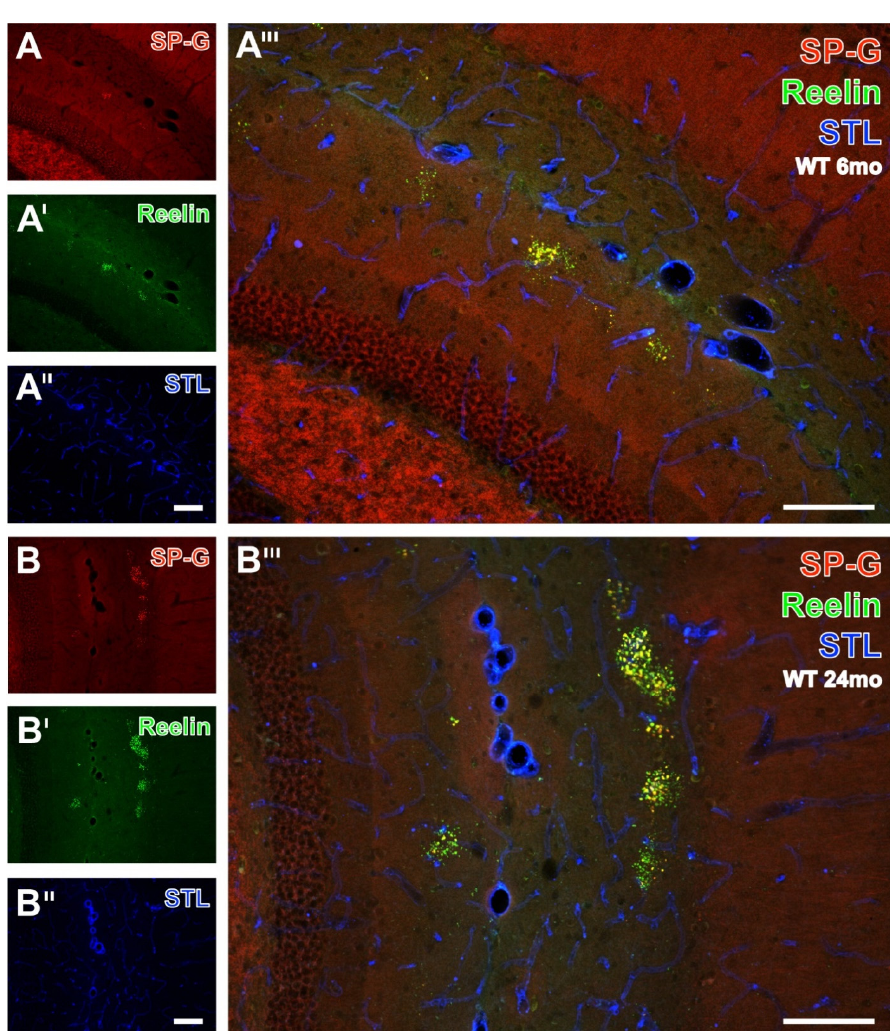
Figure 9. Double immunolabeling of SP-G- and Reelin combined with the detection of endothelia by STL in the hippocampus of 6 and 24 month-old WT mice. In a 6 month-old animal, the presented SP-G-ir remains restricted to the stratum lacunosum-moleculare of the CA1-region in a more ros- trally located part of the hippocampus and is in some cases not clustered ( A ). Concomitantly, Reelin- ir reveals apparently more dot-like structures ( A’ ) exclusively in the stratum lacunosum-moleculare. Additional counterstaining of endothelia with STL ( A’’ ) also visualizes some perpendicularly cut vessels of the fissura hippocampalis. The overlay ( A’’’ ) indicates the lacking co-occurrence of vas- culature and dot-like structures which are either mono-labeled by Reelin (green) or contain SP-G as well as Reelin (yellow). The same triple staining in the caudal, laterally positioned hippocampus from a 24 month-old WT mouse detects, in ( B ), four clusters, with SP-G-ir in the stratum radiatum of the CA2 region and one cluster in the stratum moleculare of the dentate gyrus, which are found to be also Reelin-immunopositive in ( B’ ). Simultaneously, vascular STL-binding sites ( B’’ ) clearly demarcate the fissura hippocampalis between the clusters of dots in the hippocampal stratum radi- atum and the stratum moleculare of the dentate gyrus. The overlay ( B’’’ ) shows numerous clusters